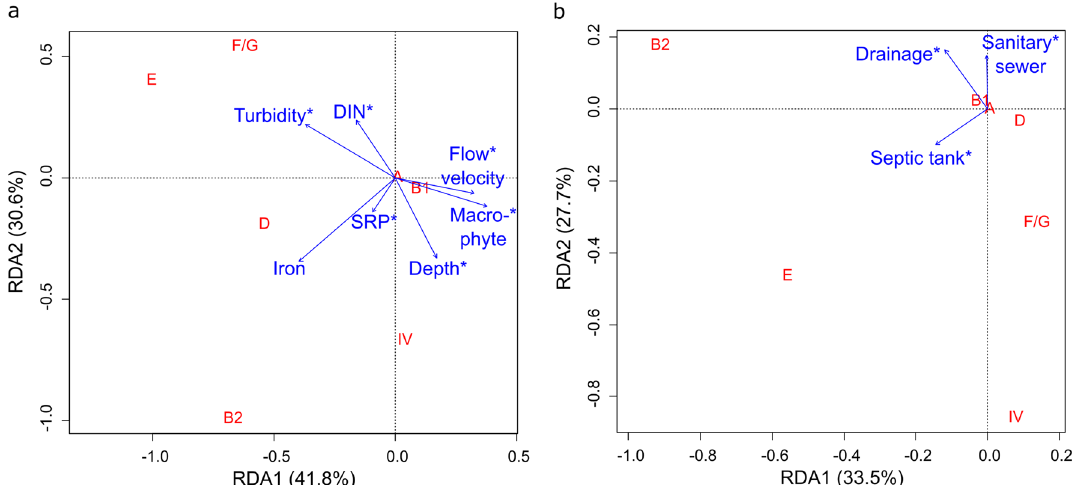
Figure 5. Independent effects of urban infrastructure and ecological habitat conditions affecting the composition of E. coli phylogroups. Biplots of partial redundancy analysis relating the occurrence of E. coli phylogroups to: ( a ) environmental and ( b ) urban infrastructure explanatory factors (scaling = 3). In each case, pRDA was performed controlling for the rest of the variable sets (including spatial effects). Significant variables, assessed using the Monte Carlo restricted permutation test (9999 permutations), are identified with an asterisk. DIN, dissolved inorganic nitrogen; SRP, soluble reactive phosphorus. Data analysis performed in R software 73 . Graphical edition in Inkscape V 0.92.4. Inkscape Project (2020). https:// inksc ape.